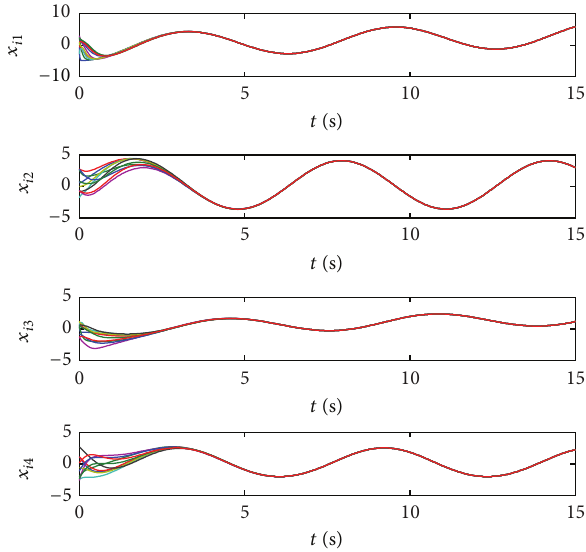
Figure 2: State evolutions of complex network with full-state coupling.